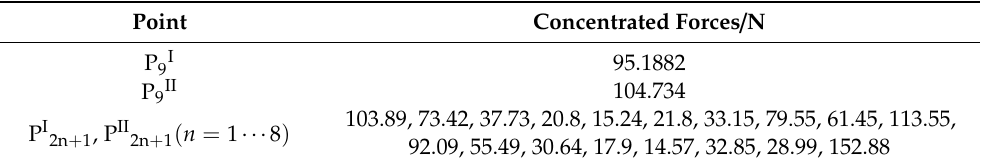
Table 5. Calculated intermediate joining